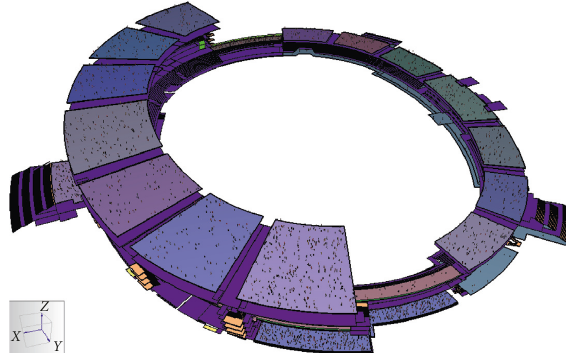
Figure 29: The scenario of